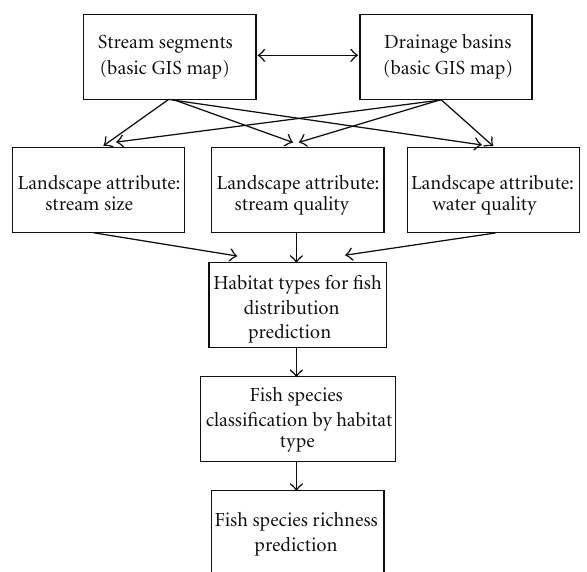
Figure 1: GIS framework for stream habitat classification and fish distribution